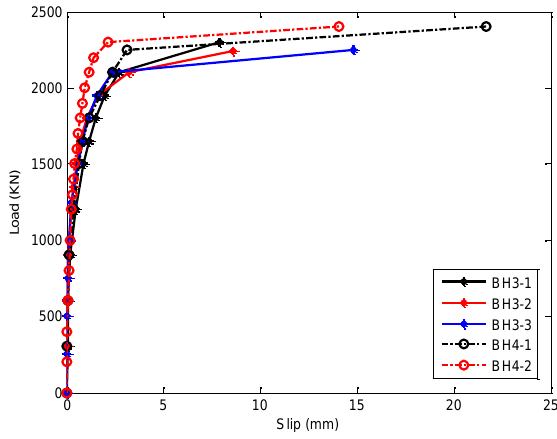
Figure 17. Load – slip relationship.